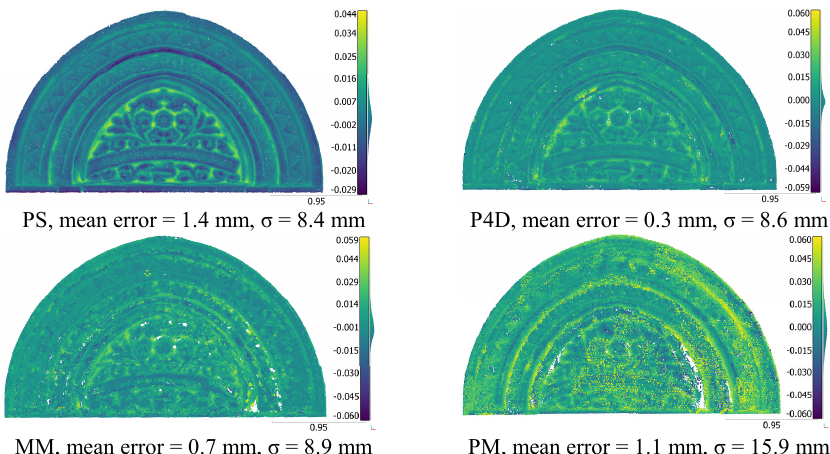
Figure 6. Comparison of dense matching results of the South-Eastern tympanum to TLS